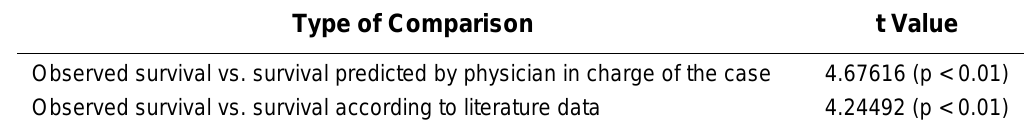
Student’s t test for Survival Period Type of Comparison Observed survival vs. survival predicted by physician in charge of the case Observed survival vs. survival according to literature